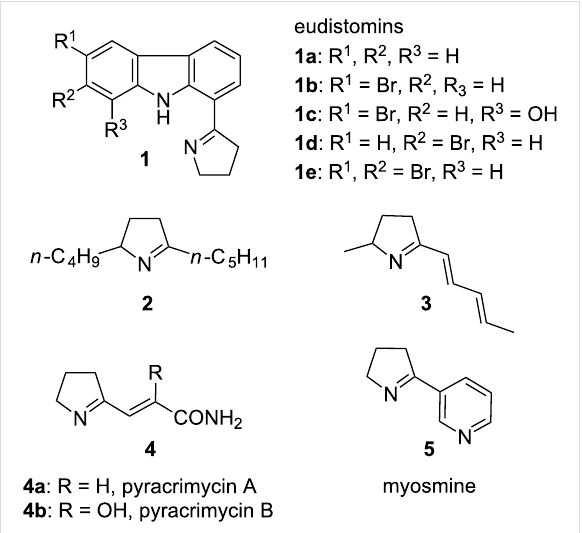
Figure 1: Natural products containing 2-substituted pyrroline residues in their core structural